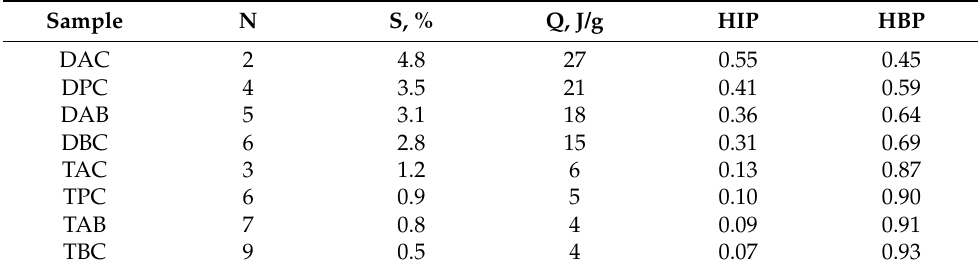
Table 4. Hydrophilic and hydrophobic properties of cellulose